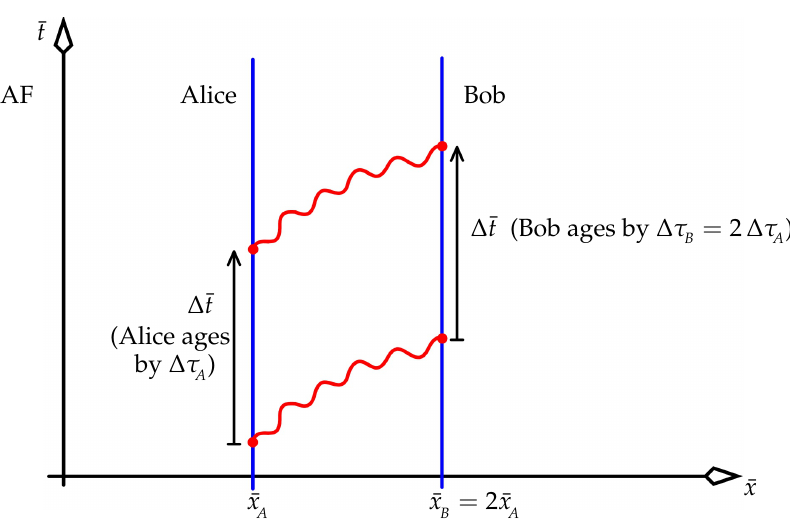
Figure 11. Earman and Glymour’s correct calculation of the redshift. They compared the lapses in proper time ( ∆ τ , ∆ τ ) for one given coordinate time ∆ ¯ t elapsing for both Alice and A B